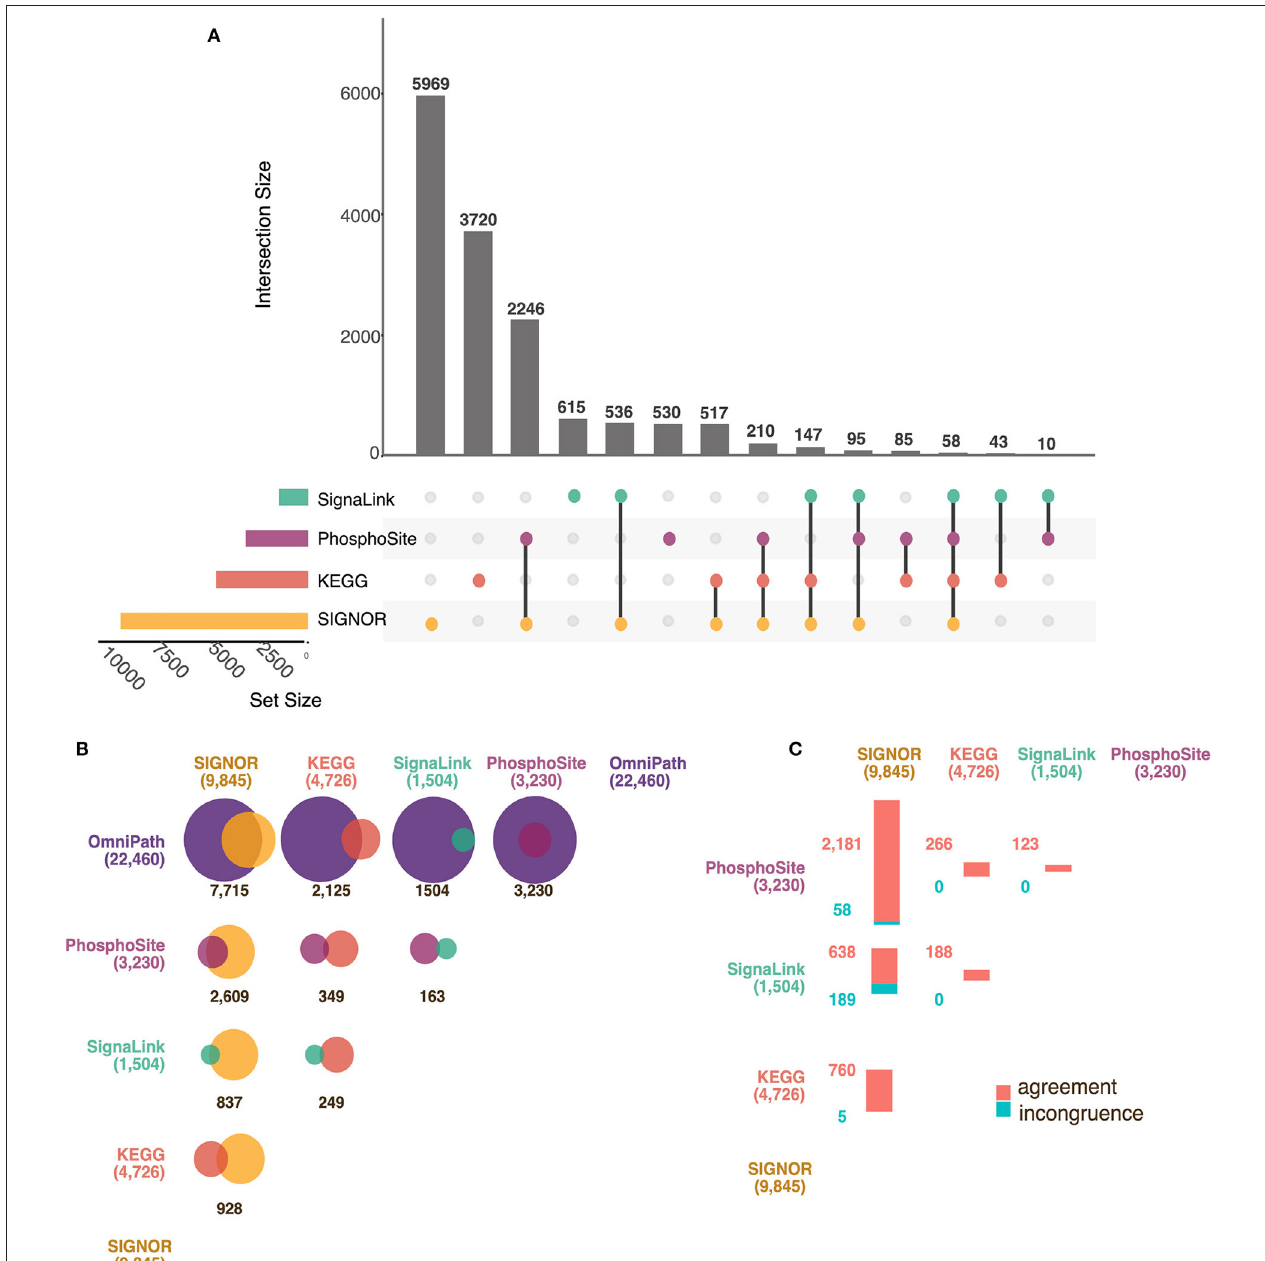
FIGURE 3 | Comparison of AF Databases. (A) UpSet Plot showing the overlaps between four primary AF resources: SIGNOR (in yellow), KEGG (in red), PhosphoSitePlus (in purple) and SignaLink (in green). The vertical bars show the number of intersecting protein pairs (regulator-target) between resources, identified as connected colored circles below the histogram. The length of the horizontal bars is proportional to the dataset size of each resource. As an example, PhosphoSitePlus, SIGNOR and KEGG share 210 interactions. (B) Proportional Venn diagrams showing the overlap between the datasets of the four primary AF resources and OmniPath: SIGNOR (in yellow), KEGG (in red), PhosphoSitePlus (in purple), SignaLink (in green) and OmniPath (dark purple). Individual set sizes are in parenthesis. (C) Matrix of bar plots showing the number of interactions between pairs of proteins whose effect, up- down-regulation is annotated in an opposite way in each pair of primary resources. Agreement and disagreement are shown in red and blue,